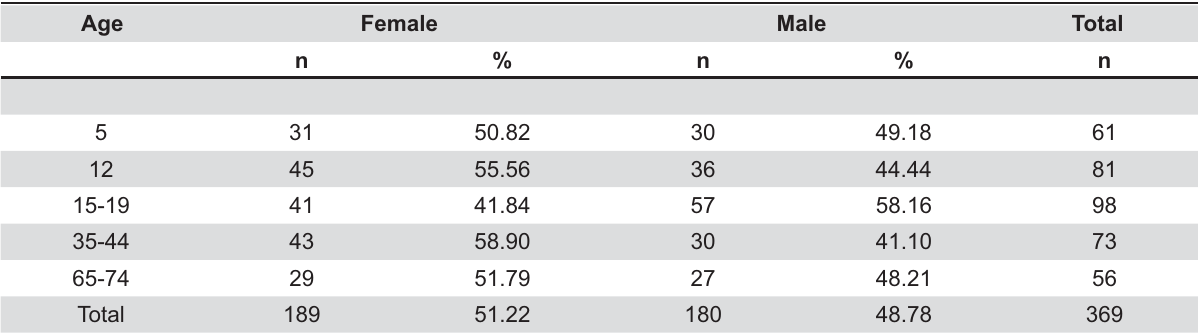
Table 1- Sample distribution according to age and